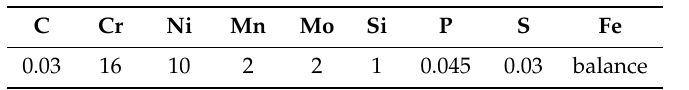
Table 1. Chemical composition of 316L austenitic stainless steel (%wt.) [56] C Cr Ni Mn